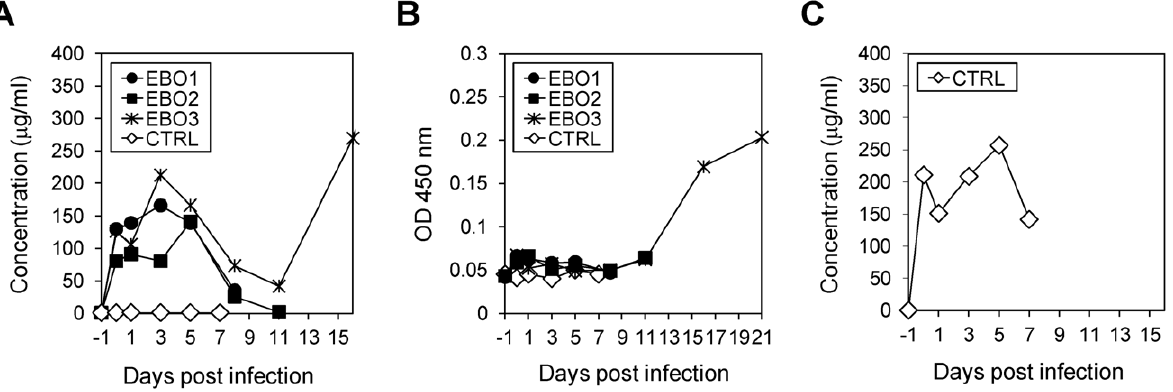
Figure 4. Serum antibody levels after ZEBOV challenge. Serum samples were collected from animals given the GP-specific MAb mixture or ch61 during the period of the experiments of prophylactic treatments. Antibodies specific to GP (A), NP (B), and influenza virus HA (C) were detected by ELISA, as described in Materials and Methods. Levels of anti-HA antibody were measured in the animal given only the control MAb (anti-HA, ch61). Spontaneous induction of GP-specific IgG in the surviving animal after day 11 was detected due to cross-reactivity of the secondary antibody used in the ELISA. doi:10.1371/journal.pone.0036192.g004 PLoS ONE |